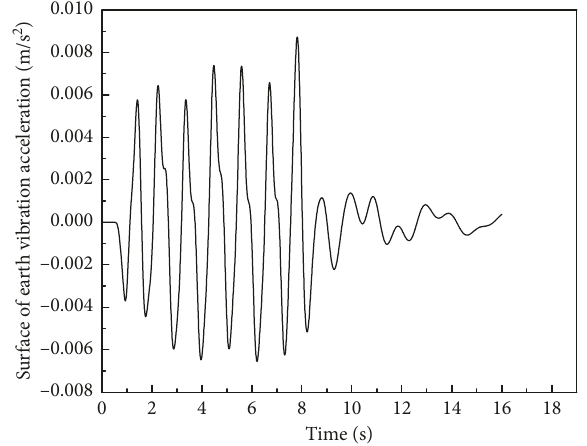
Figure 17: The time history of the acceleration.